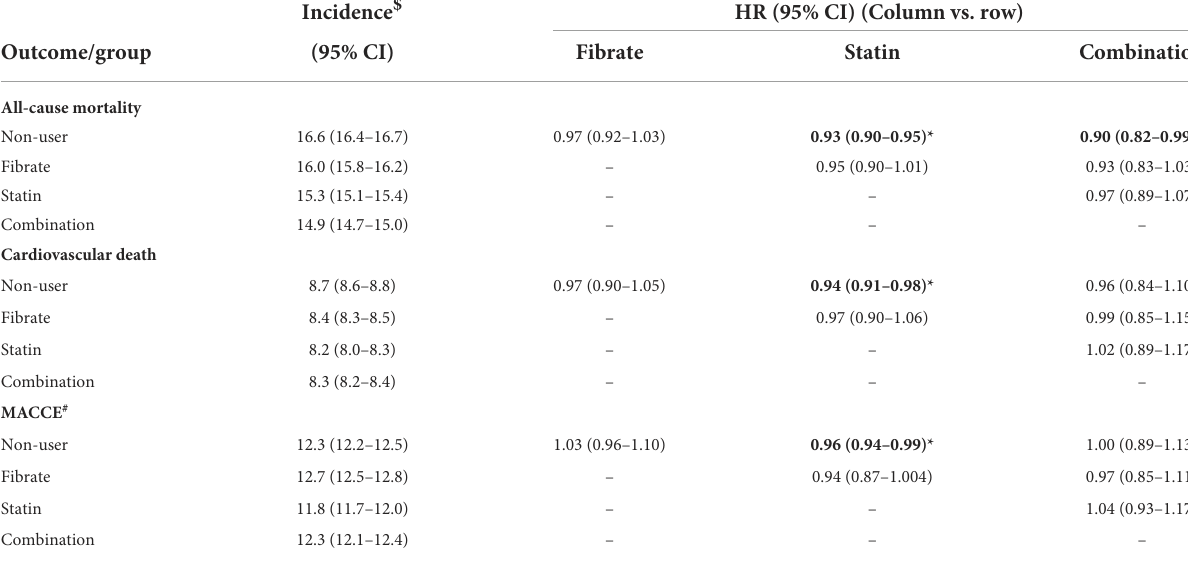
TABLE 2 Follow up outcome for the dialytic patients according to the use of fibrate and statin in the IPTW-adjusted cohort. Incidence $ HR (95% CI) (Column vs.